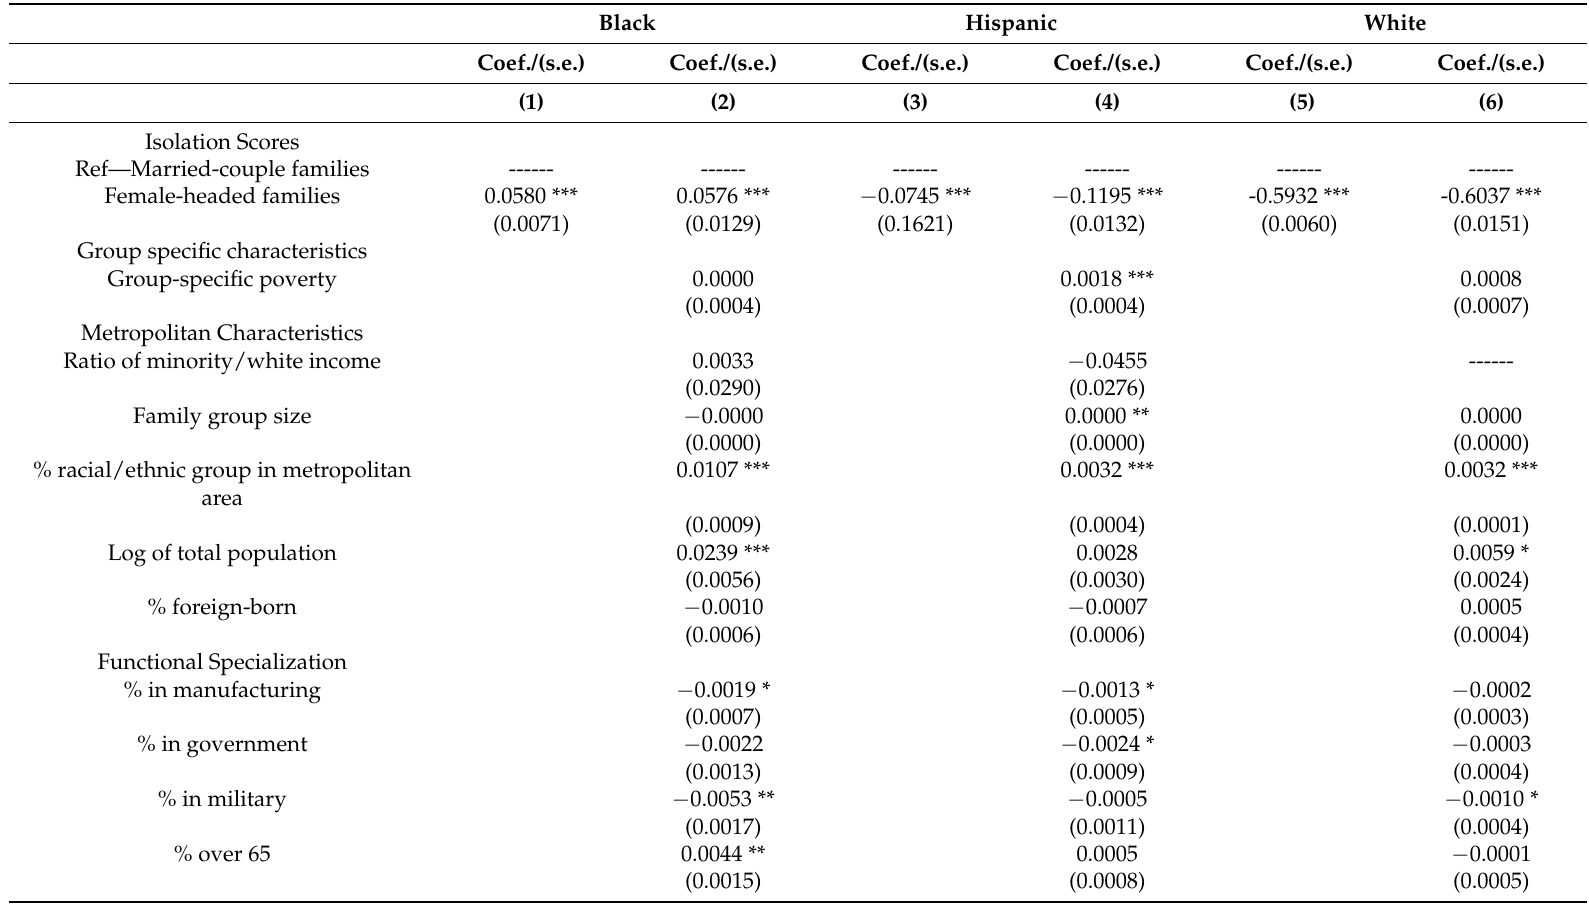
Table 7. Linear regression models of the association between family structure and the Isolation Index within race/ethnicity, using the 1990–2010 NCDB and 1990–2010